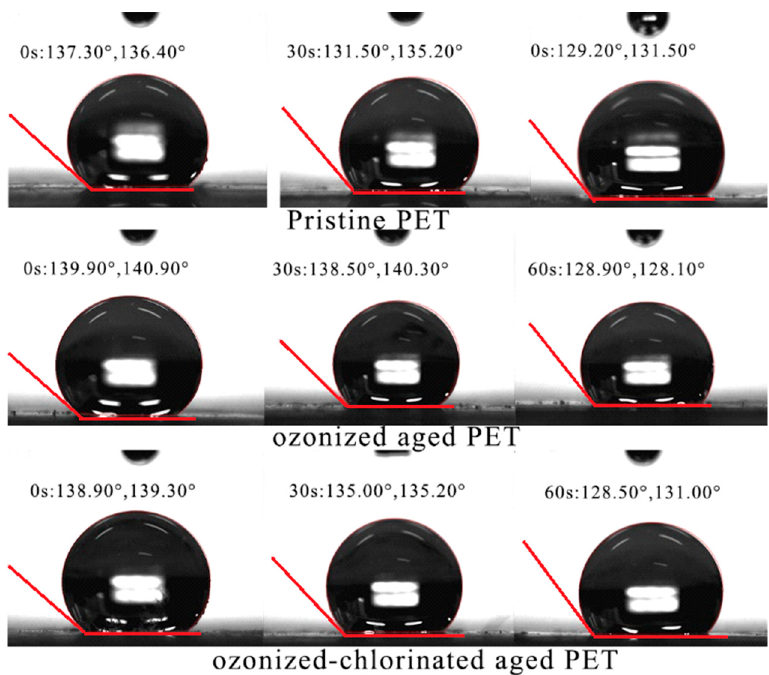
Figure 2. Contact angle (left) of pristine PET, ozonized PET, ozonized − chlorinated PET.